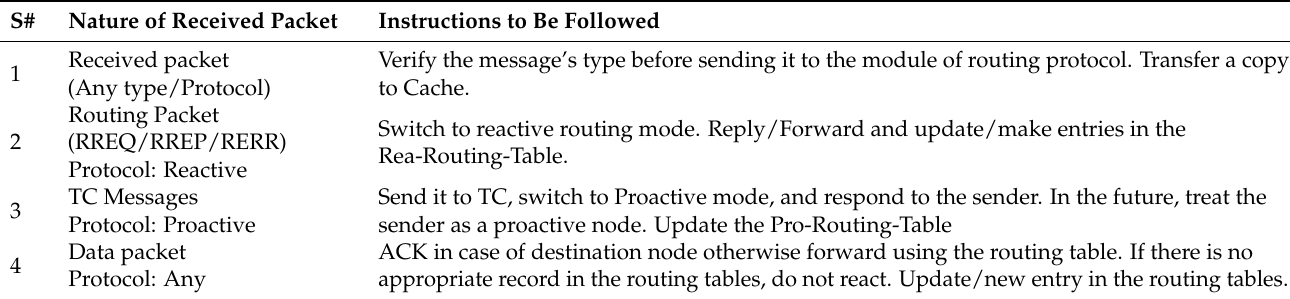
Table 7. Smart nodes’ operational steps.